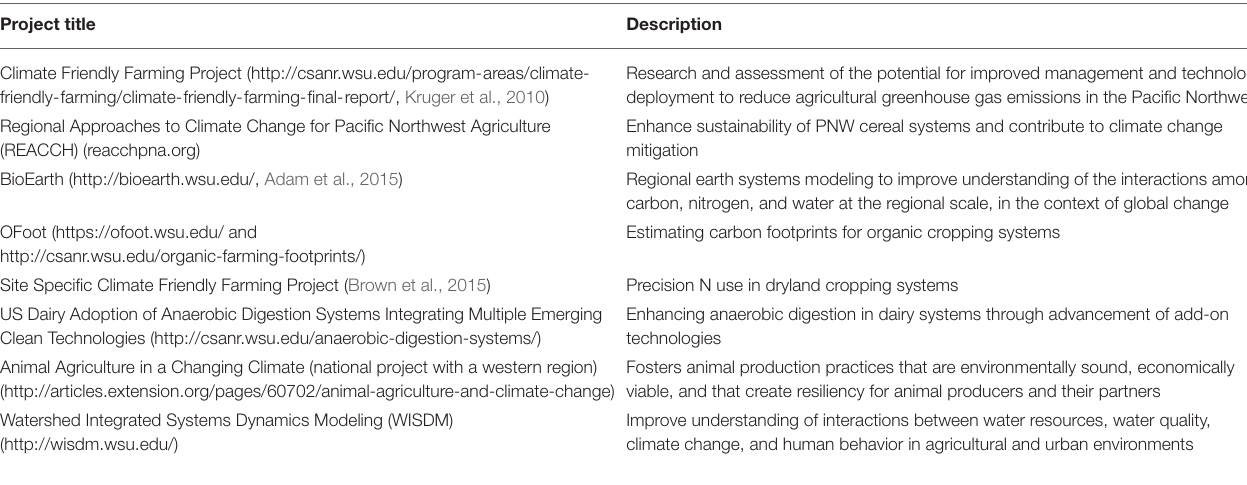
TABLE 1 | Major climate change and agriculture-related efforts in the Pacific Northwest from 2003 to